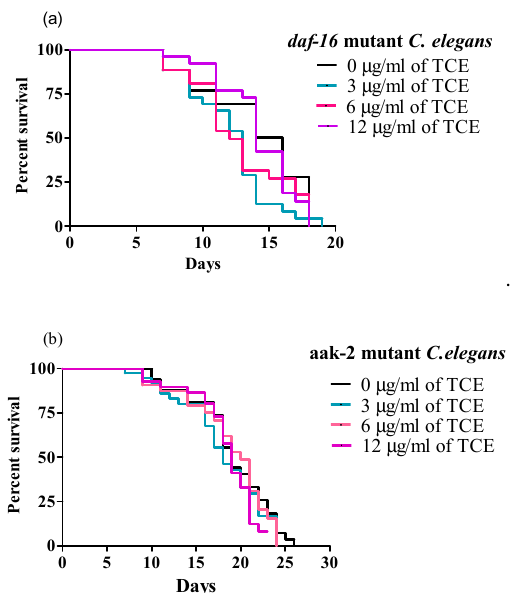
Figure 4. Tart cherry extract (TCE) did not extend lifespan in daf-16 and aak-2 mutant C. elegans . (a) Treatments with 3 μ g/ml (blue), 6 μ g/ml (pink), and 12 μ g/ml (purple). TCE had mean lifespans (MLS) of 12.65 ± 0.43, 13.96 ± 0.51, and 14.29 ± 0.74, respectively in daf-16 mutant C. elegans compared to control or no treatment (0 μ g/ml, MLS 13.57 ± 0.51, black) grown at 20 °C . (b). Treatments with 3 μ g/ml (blue, MLS: 14.83 ± 0.15), 6 μ g/ml (pink, MLS: 14.41 ± 0.18), and 12 μ g/ml (purple, MLS: 15.64 ± 0.83) TCE did not increase MLS in aak-2 mutant C. elegans, compared to control or no treatment (0 μ g/ml, MLS: 15.68 ± 0.20, black) grown at 20°C. Each lifespan experiment was repeated at least three independent times with similar results. Statistical significance considered at p < 0.05 using the log- rank (Mantel–Cox) test.